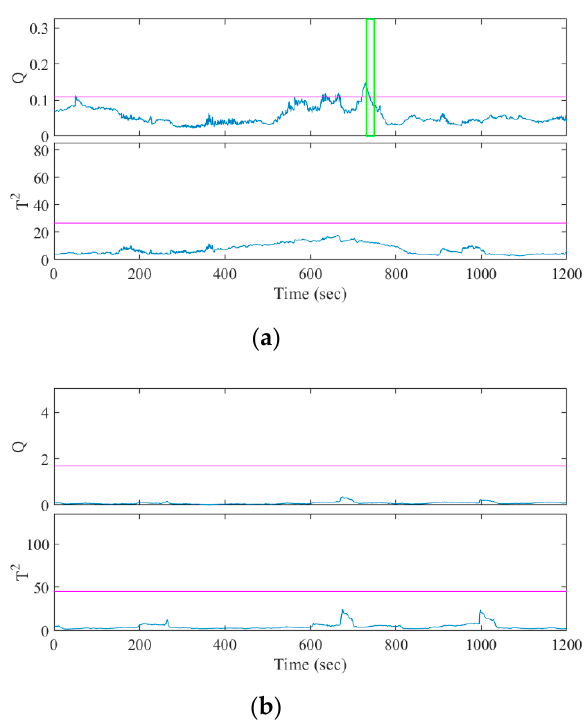
Figure 5. Result of MSPC analysis for the interictal episodes of ( a ) patient A, selected to include false positives; and ( b ) patient B, without the false positives.